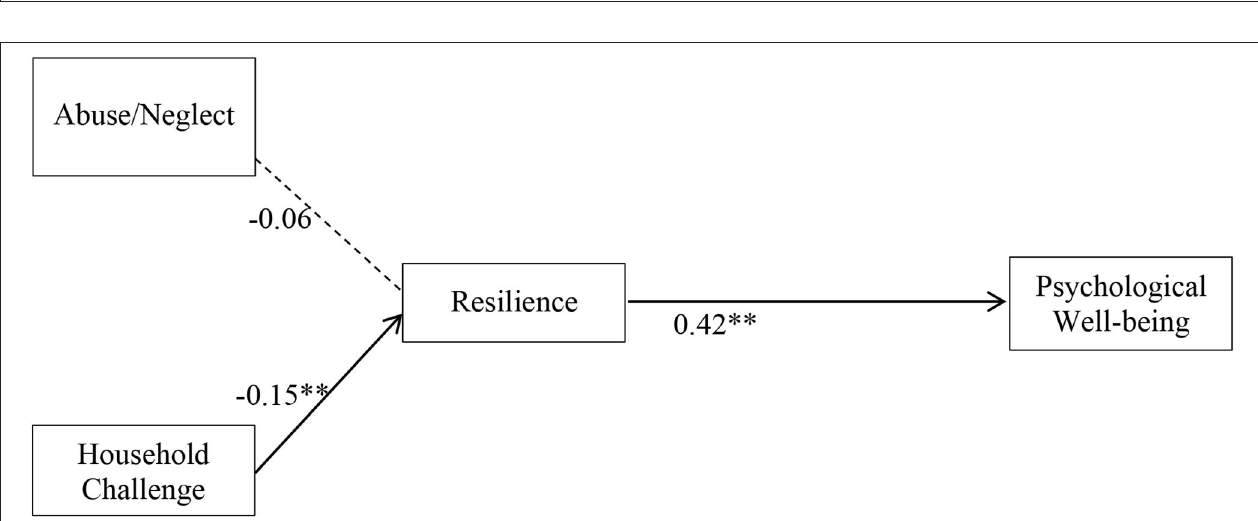
FIGURE 3 | Structural equation modeling of ACE dimensions on resilience and psychological well-being for males. N = 1,871. ** p < 0.01. Solid line, significant standardized path coefficient; Dotted line, non-significant standardized path coefficient.